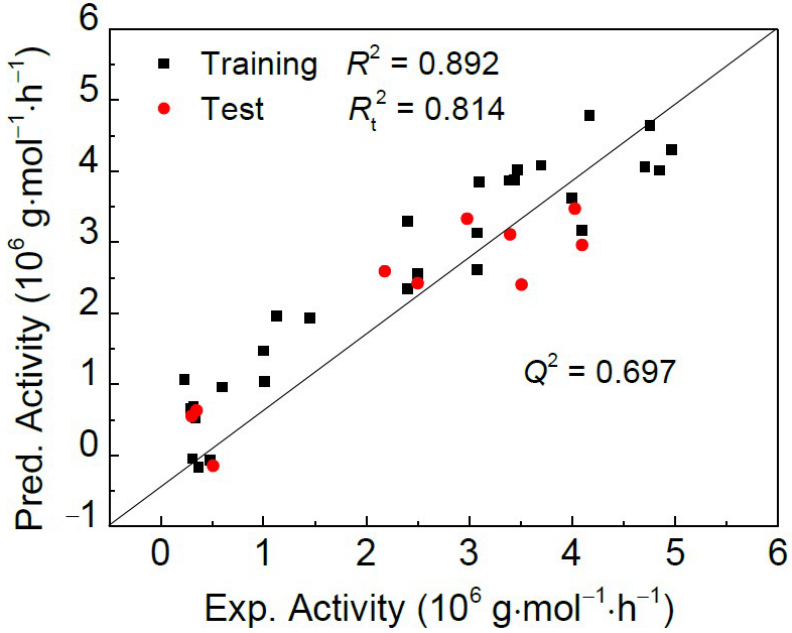
Figure 2. Experimental catalytic activities versus predicted values by the 2D-QSPR model for the training set and test set.